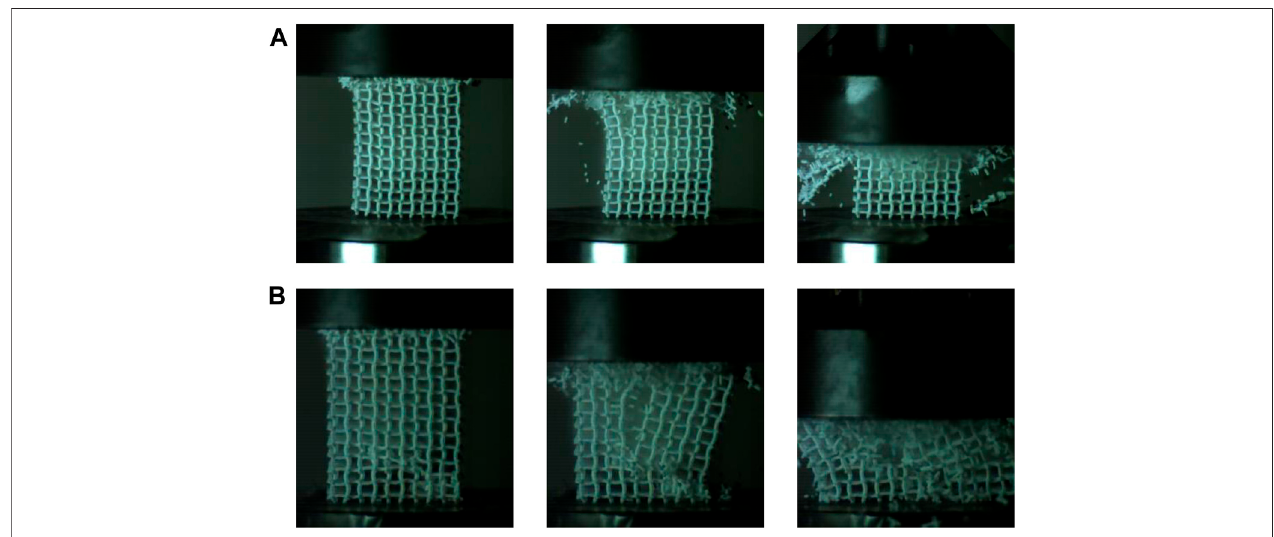
FIGURE 12 | Typical damage pattern for the specimen: (A) CCF1-1-1, _ ε (cid:2) 71.4 s − 1 (B) CCF1-2-1, _ ε (cid:2) 2.14 × 10 2 s − 1 .